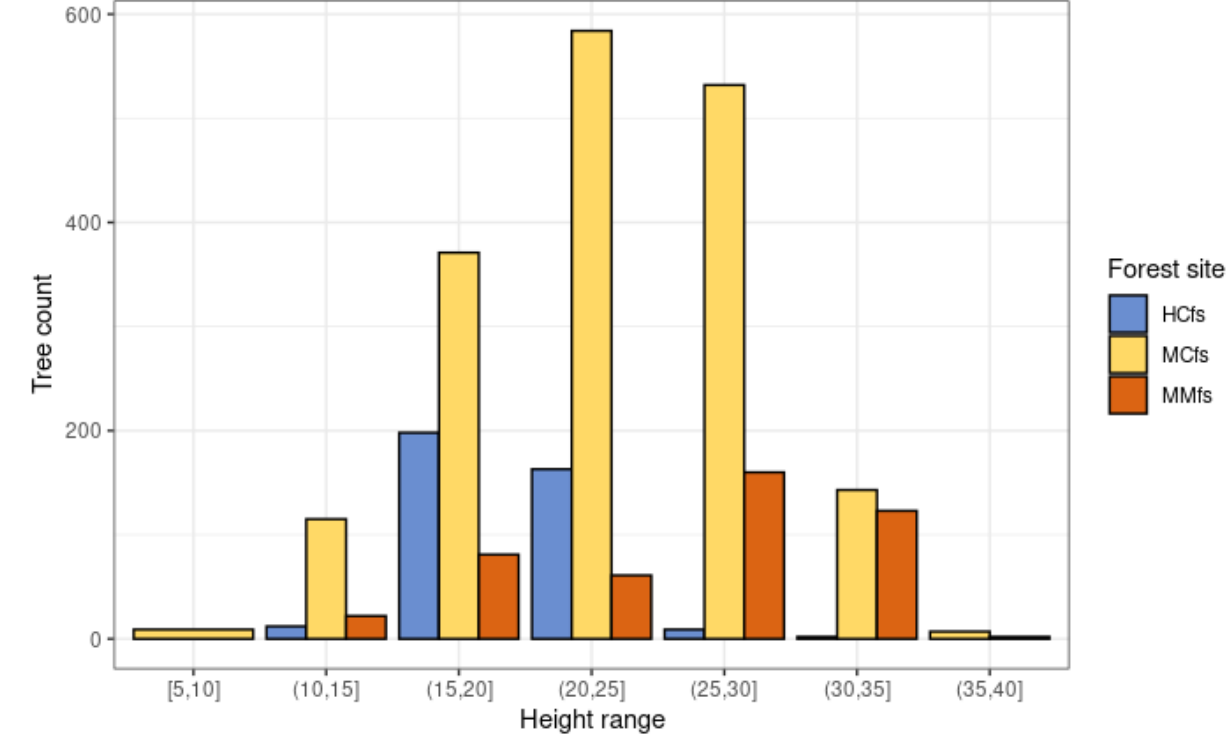
Figure 11. The count of Scots pine trees in tree height ranges (wysoko ść na podstawie HmP95 i danych ALS z 2007 roku) across different forest site groups: hydrogenic coniferous forest sites (HCfs), mineral forest sites (Mfs), mineral mixed forest sites (MMfs).